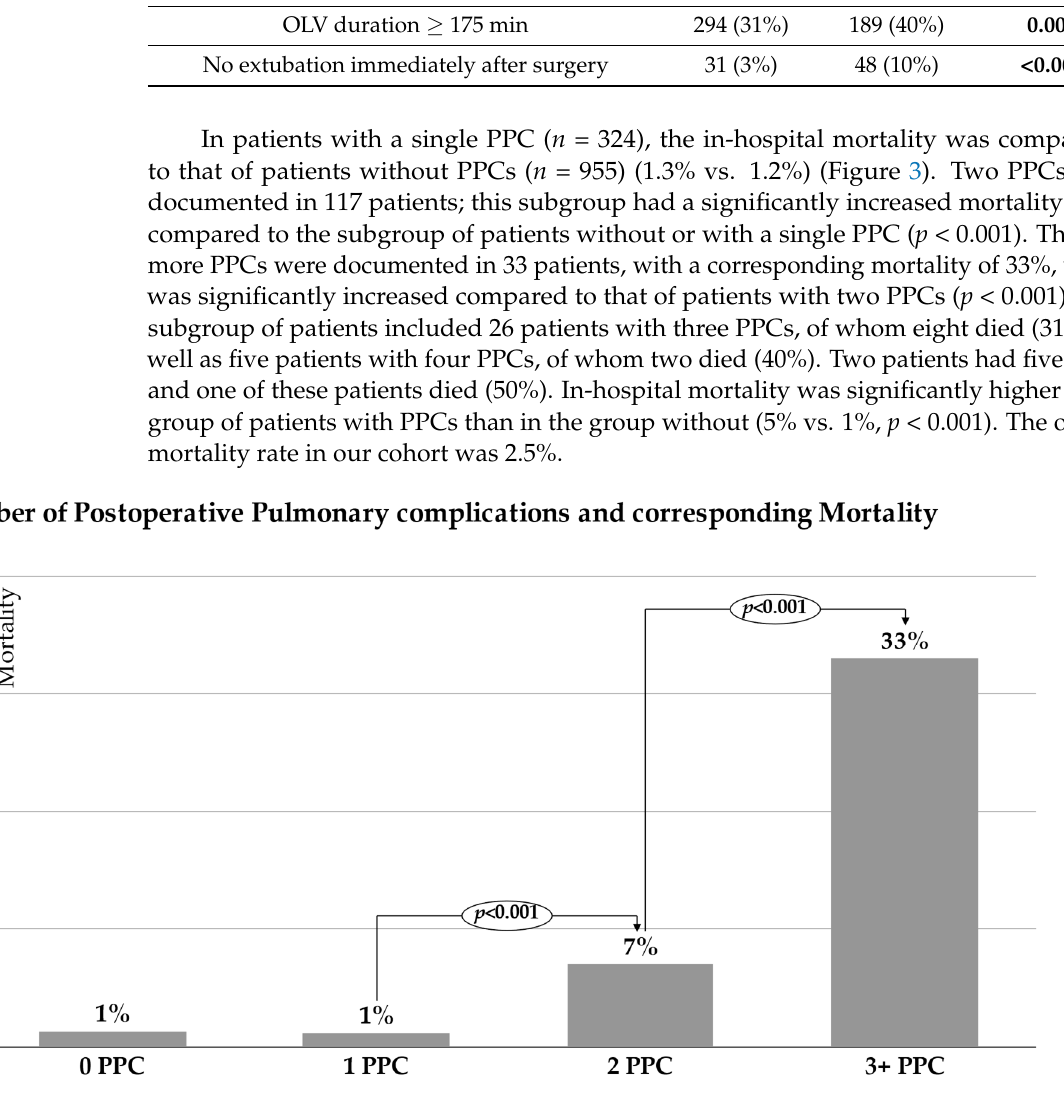
Figure 3. Number of postoperative pulmonary complications and corresponding mortality in per- centages regarding cases with and without